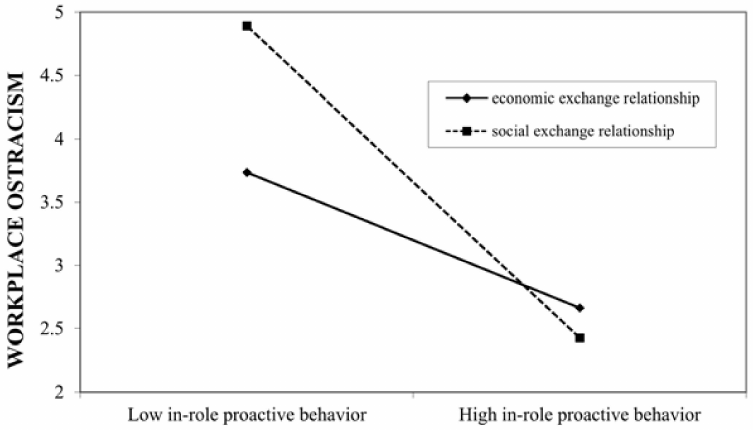
Figure 3. The interactive effect of in-role proactive behavior and exchange relationship in HR practices on workplace